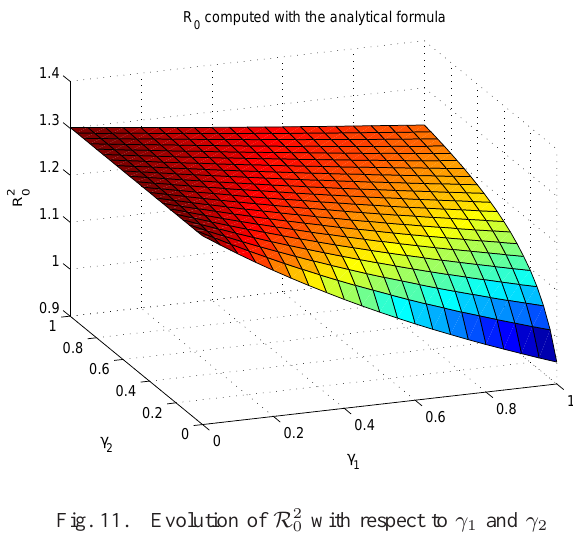
Fig. 11. Evolution of R 2 0 with respect to γ 1 and γ 2